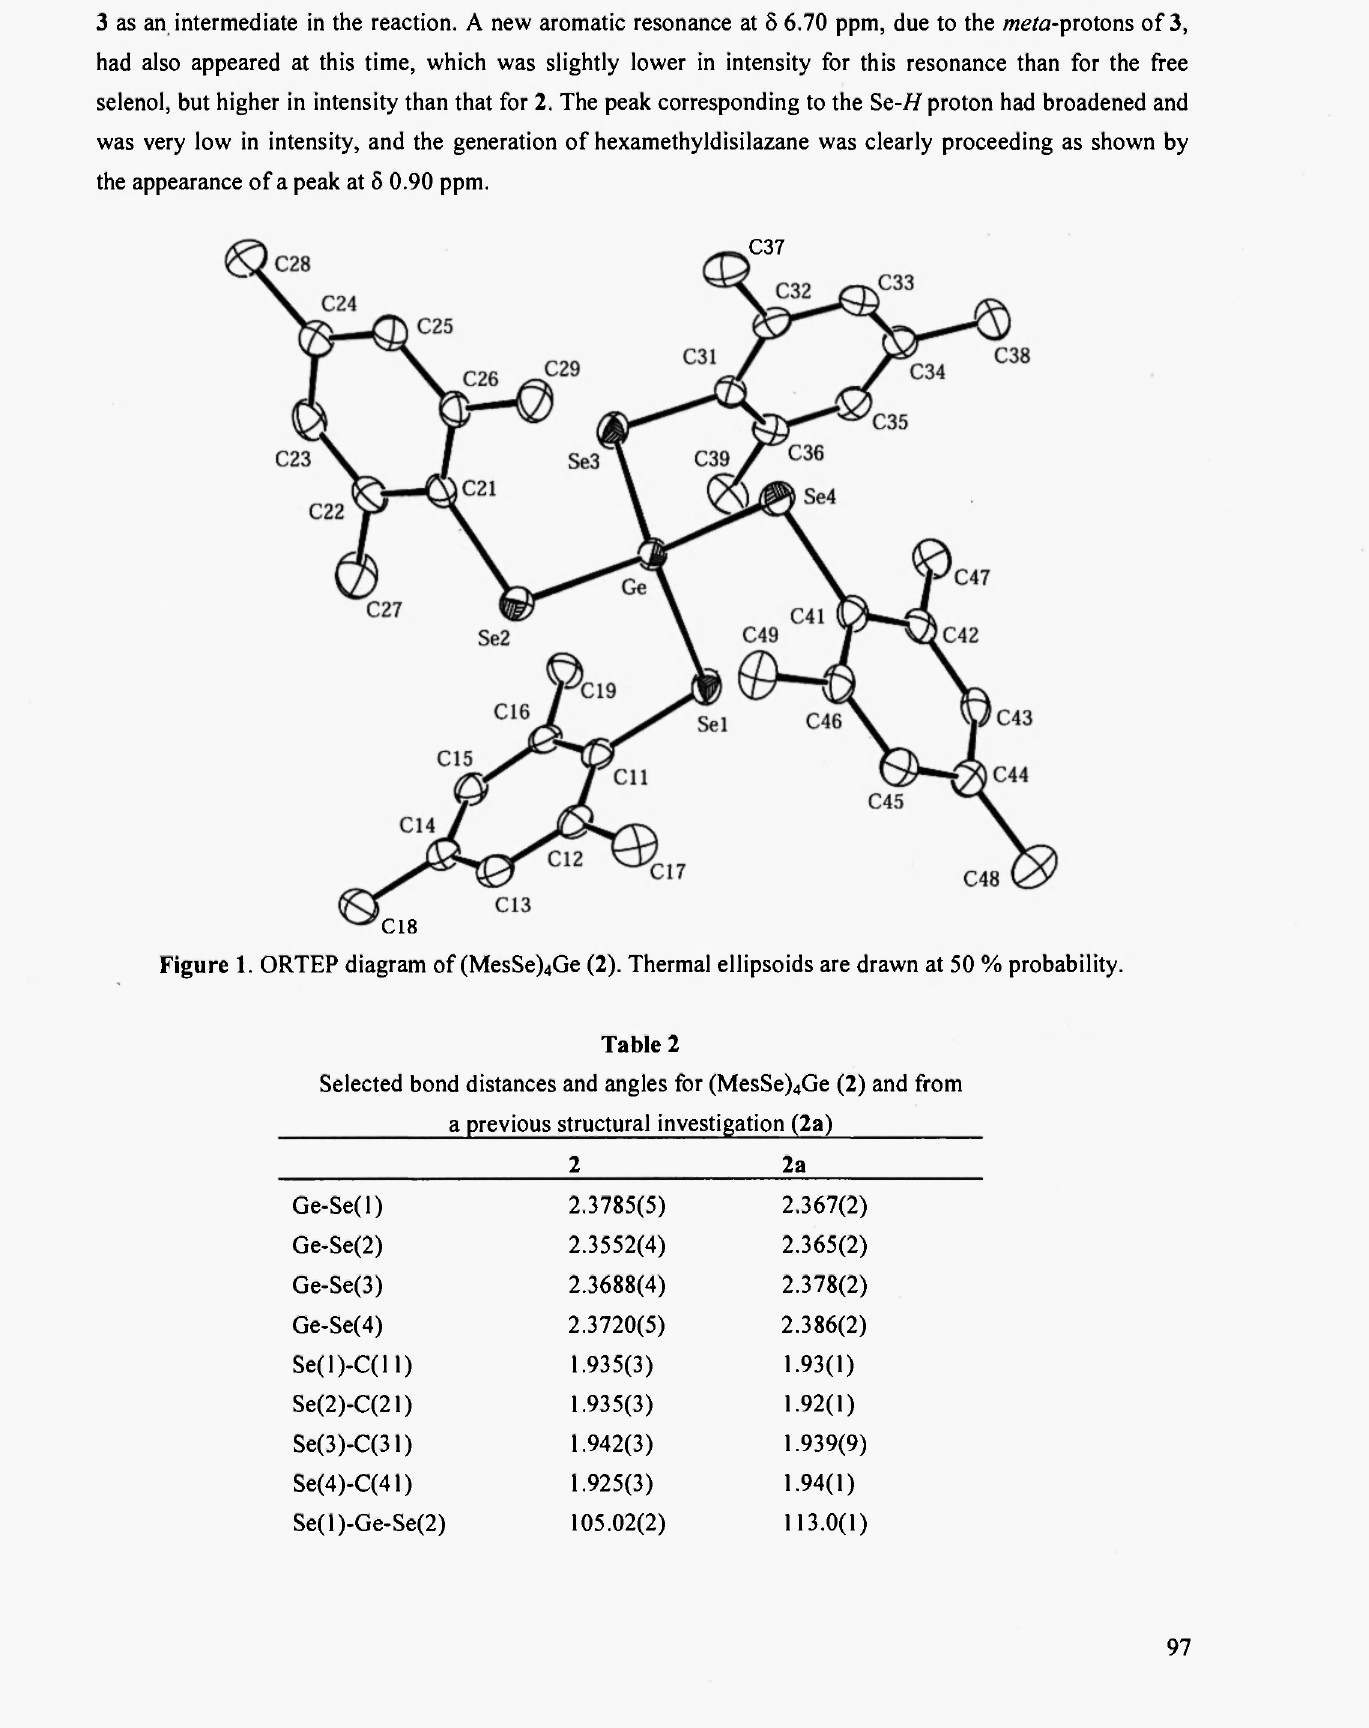
Figure 1. ORTEP diagram of (MesSe) 4 Ge (2). Thermal ellipsoids are drawn at 50 % probability.